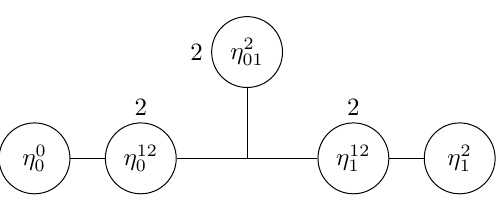
Figure 7 . Codimension-three enhancement of SU(2) (cid:2) G This (cid:12)ber is of type II (cid:3) (with dual graph e E 8 ) with contracted nodes.